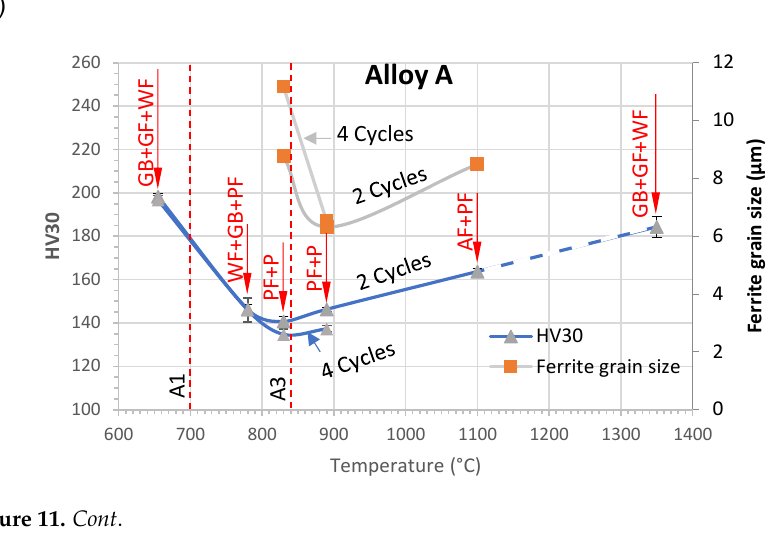
Figure 10. Effect of applying 2 Cycles ( left ) and 4 Cycles ( right ) on the formed microstructure of alloy A.